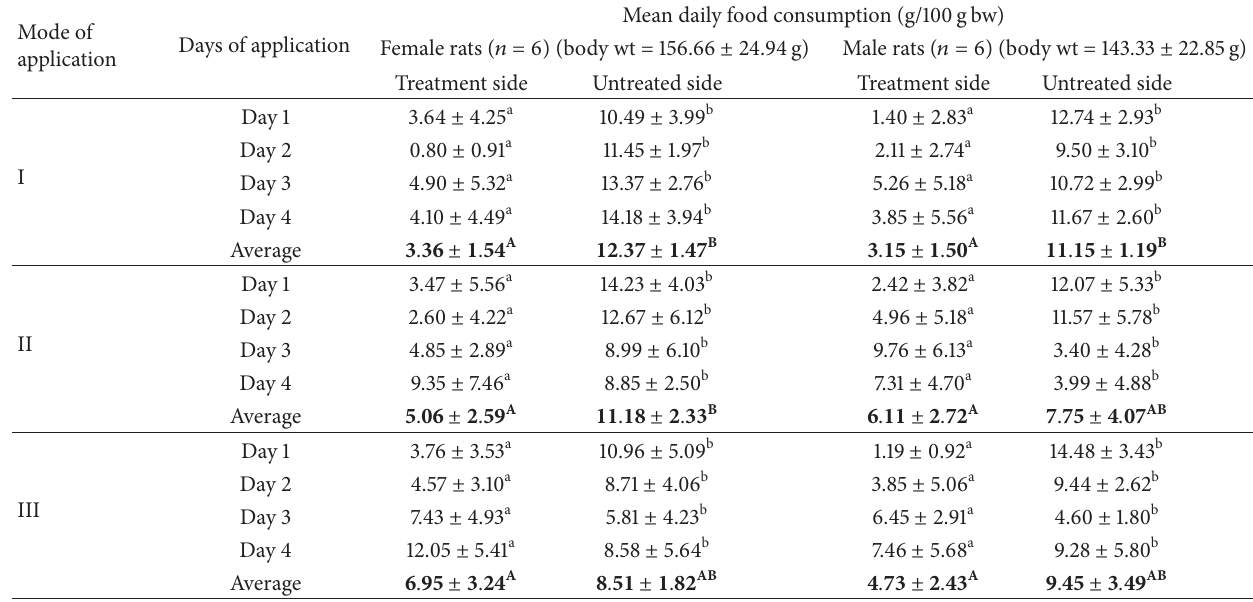
Table 2: Mean daily food consumption by Rattus rattus in response to 10% eucalyptus oil applied as spray. Mode of